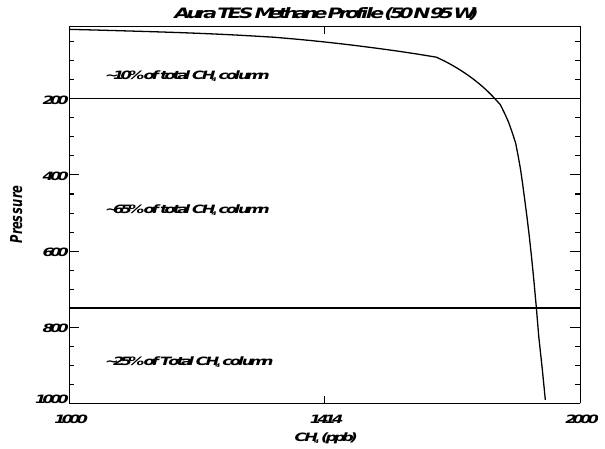
Figure 1. A retrieved methane profile from the Aura TES instru- ment during July 2009.